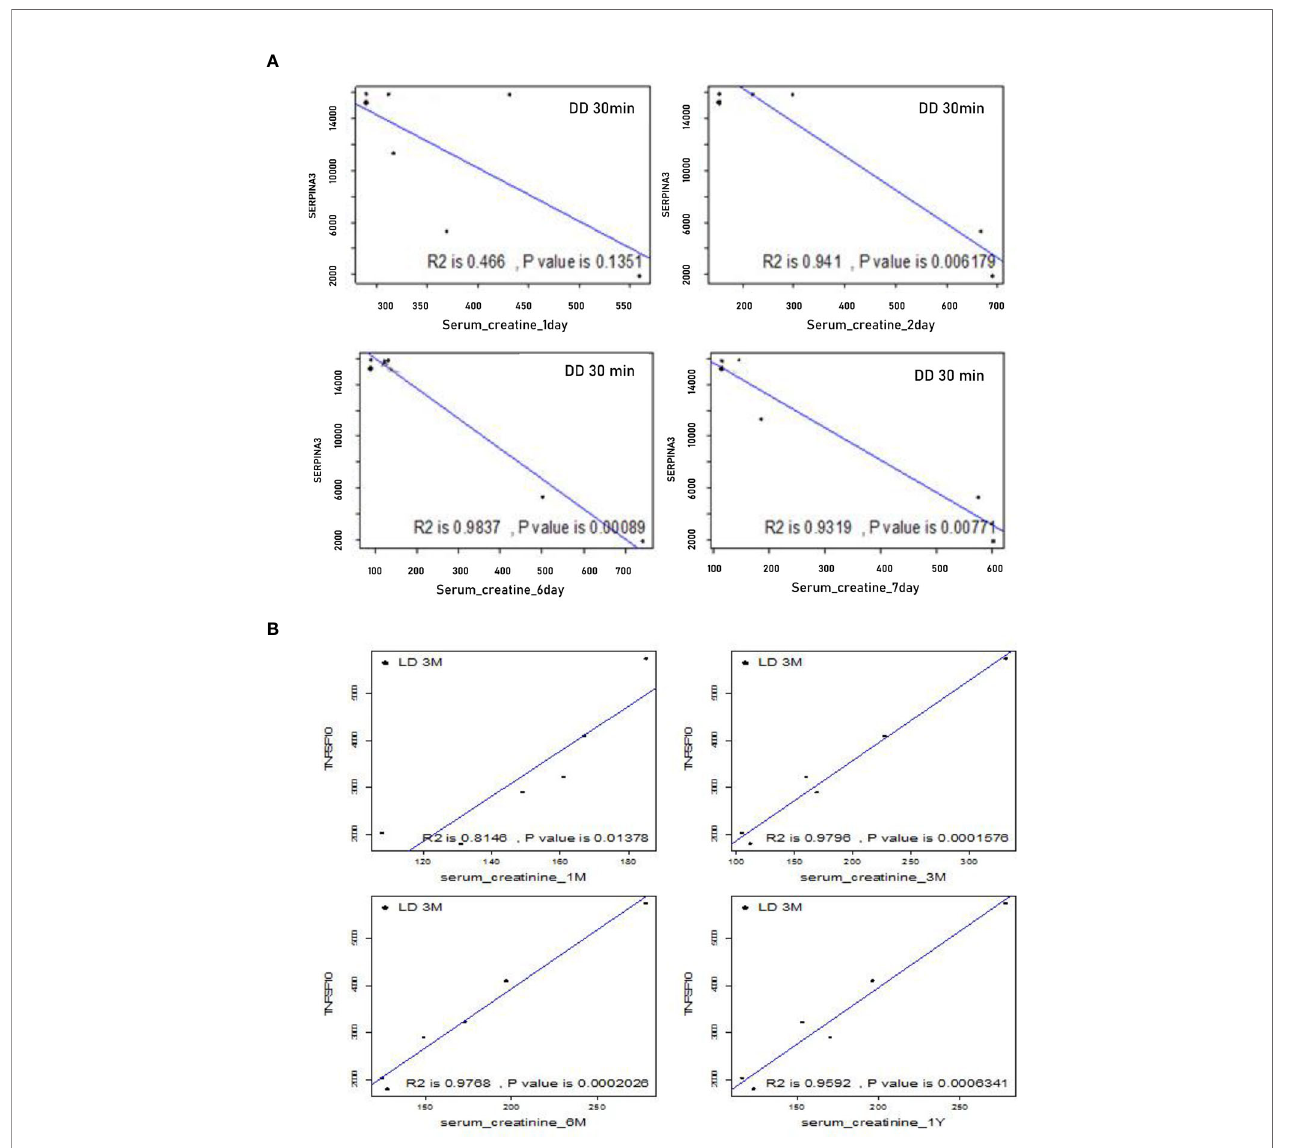
FIGURE 9 | Correlations between microarray analysis detected DEGs and renal function in the fi rst cohort of 24 biopsies. (A) Negative correlations between SERPINA 3 and SCr at early time points from day 1 to 7; (B) Positive correlations between TNFSF10 and SCr at later time points from 1, 3, 6 to 12